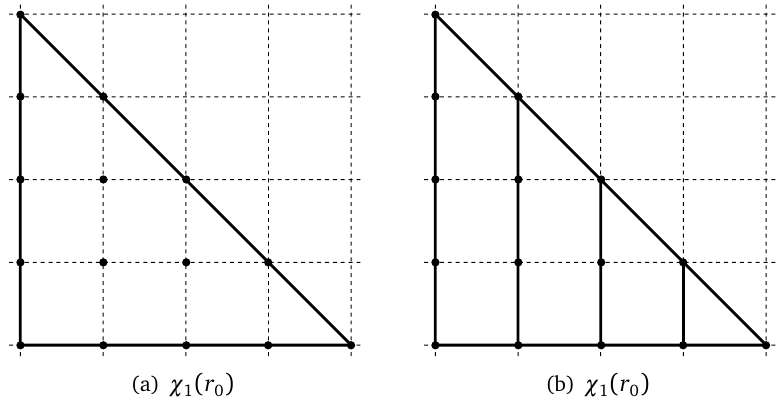
× (cid:90) ) and a partial resolution with N N